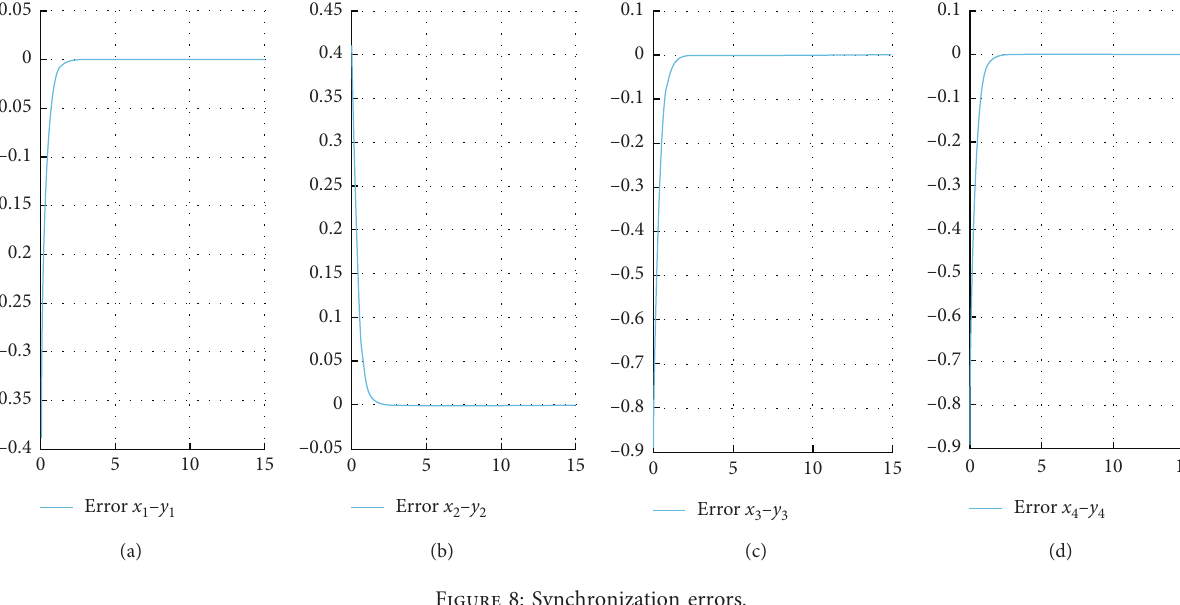
, x , x , x ) � ( 0 . 01 , 0 . 01 , 0 . 01 , 0 . 01 ) and 1 2 3 4 0